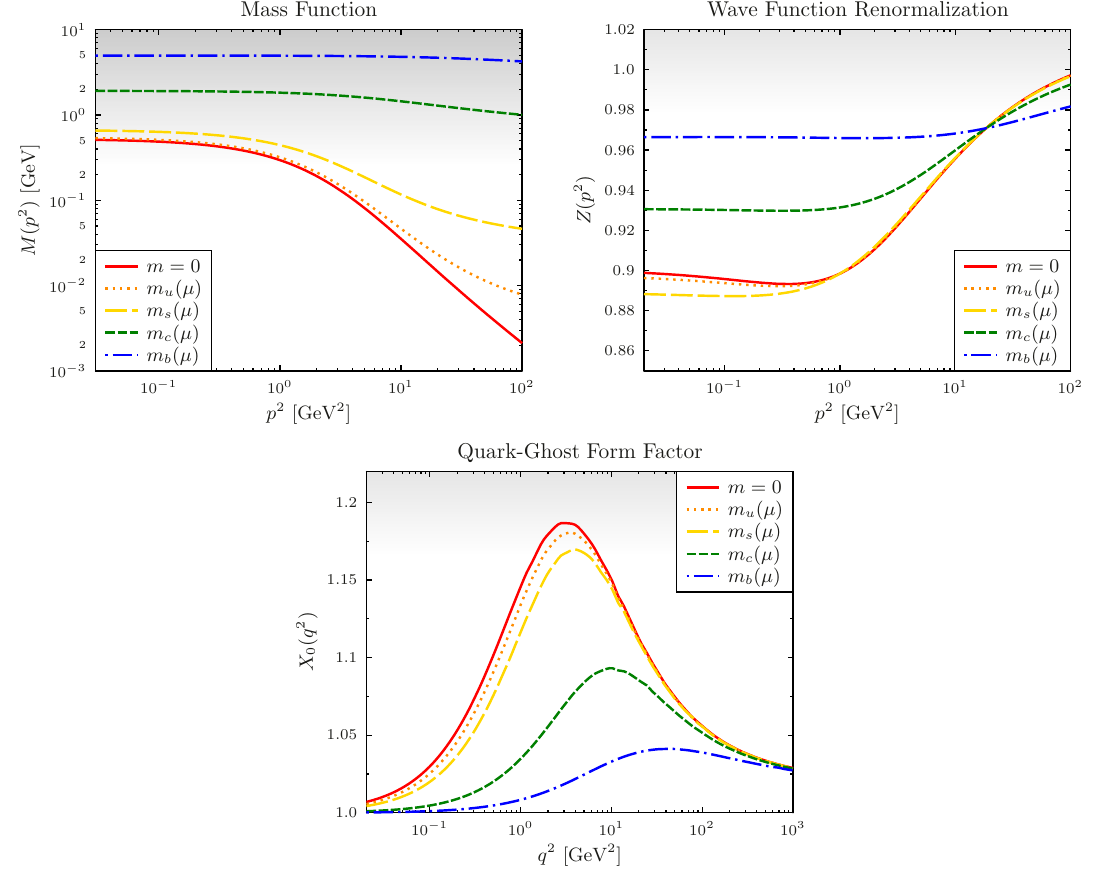
Figure 6 . Flavor dependence of M ( p 2 ) , Z ( p 2 ) and X 0 ( q 2 ) obtained with the gluon- and ghost propagators of set II [35, 36]. The DSE (2.15) is solved with the vertex Γ µ ( k, p ) = Γ L and the associated form factors in eqs. (2.44)–(2.55). The strong coupling is α s ( µ ) = 0 . 3 and the current quark masses are: m u,d ( µ ) = 25 . 0 MeV, m s ( µ ) = 82 . 1 MeV, m c ( µ ) = 1 . 304 GeV